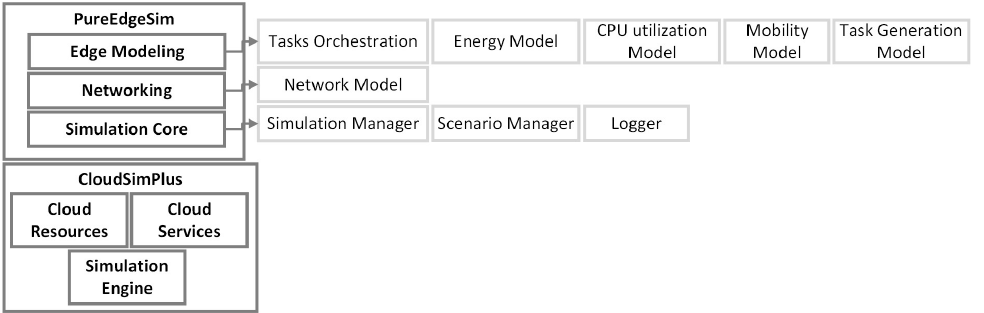
Figure 4. PureEdgeSim Architecture (Adapted from